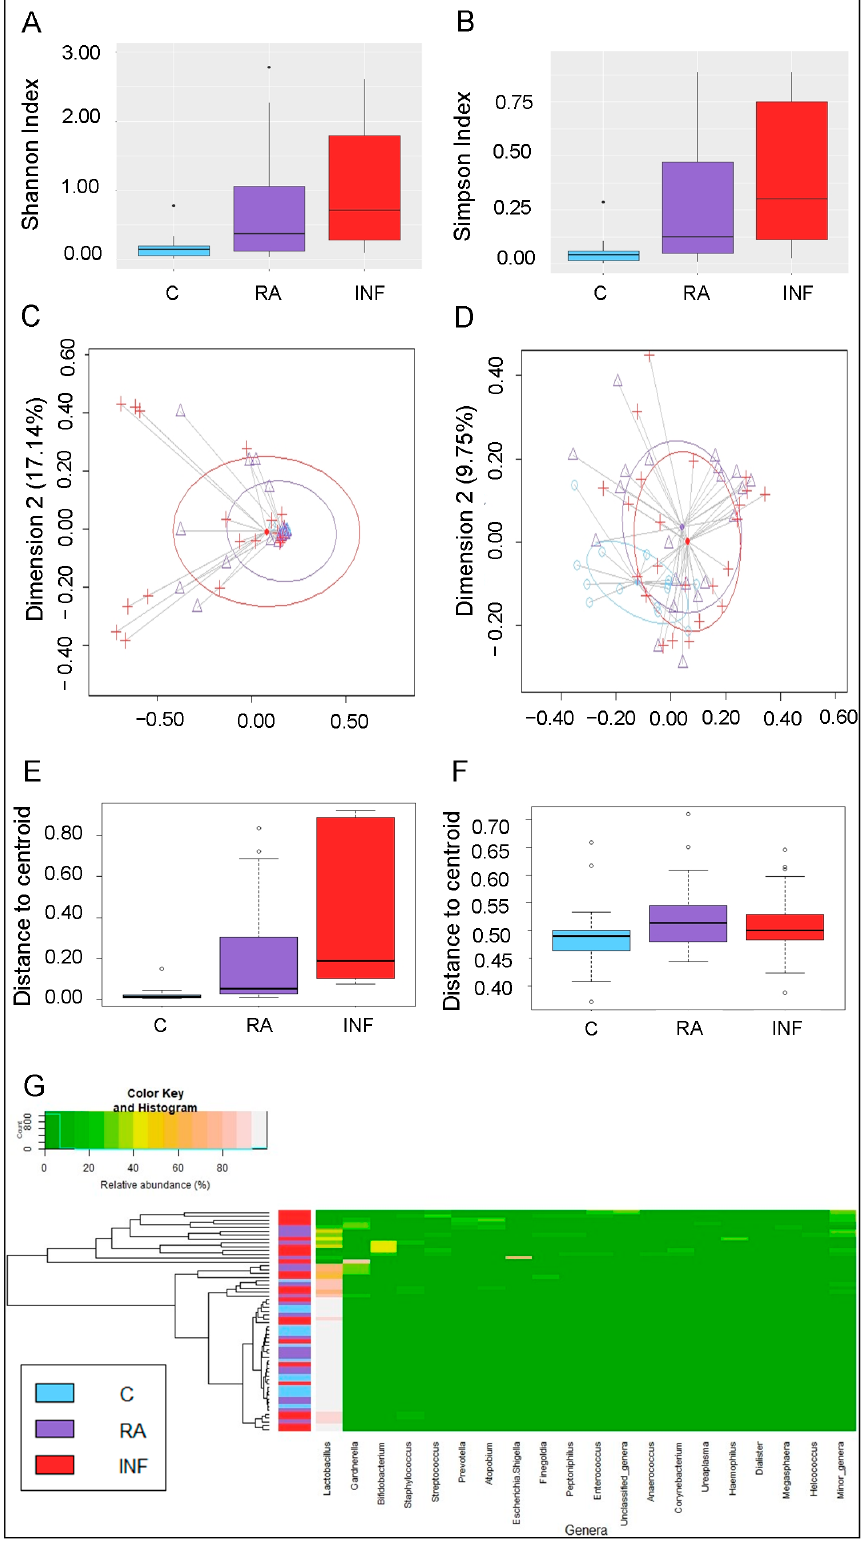
Figure 6. Metataxonomic profiles of CVL samples of healthy fertile women (C; bluish green), women with repetitive abortion (RA; purple) and women with infertility of unknown origin (INF; red). ( A ) Comparison of alpha diversity at genus level calculated using the Shannon index between the three groups of women. ( B ) Comparison of alpha diversity at genus level calculated using the Simpson index between the three groups of women. ( C ) Principal coordinate analysis